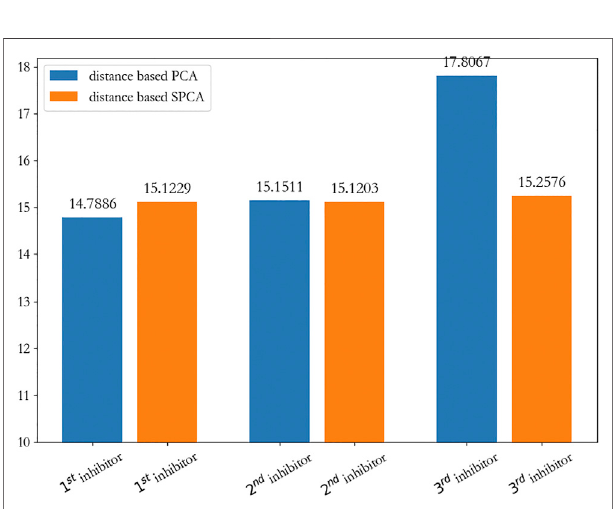
FIGURE 8| The sum of the distancefrom the new inhibitor tothe seeds.